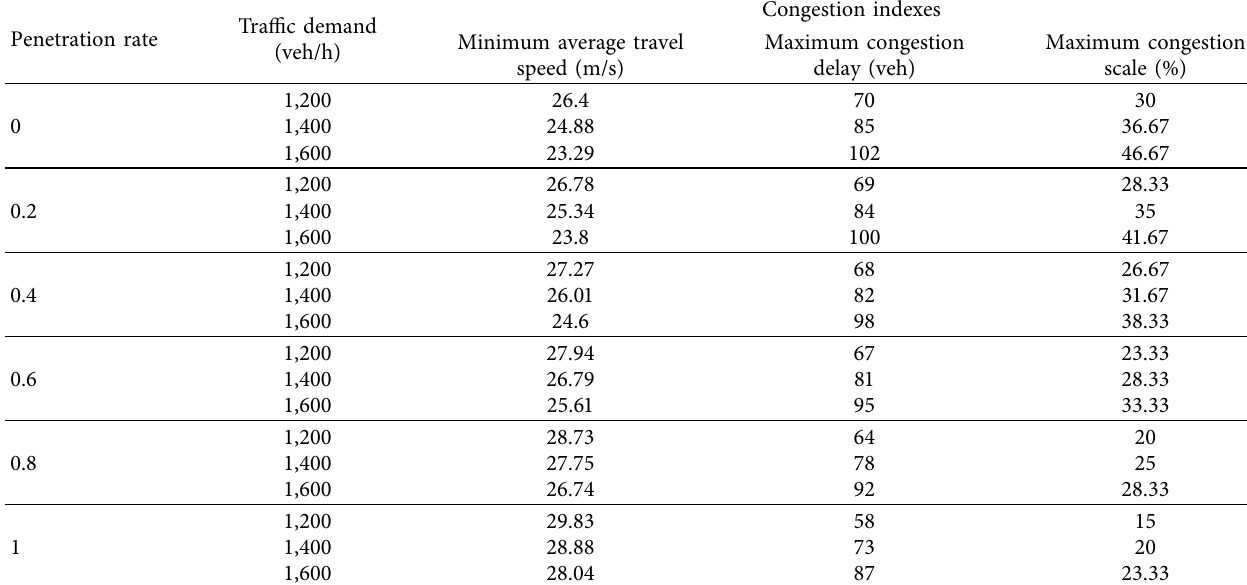
Table 4: Congestion indexes under different traffic